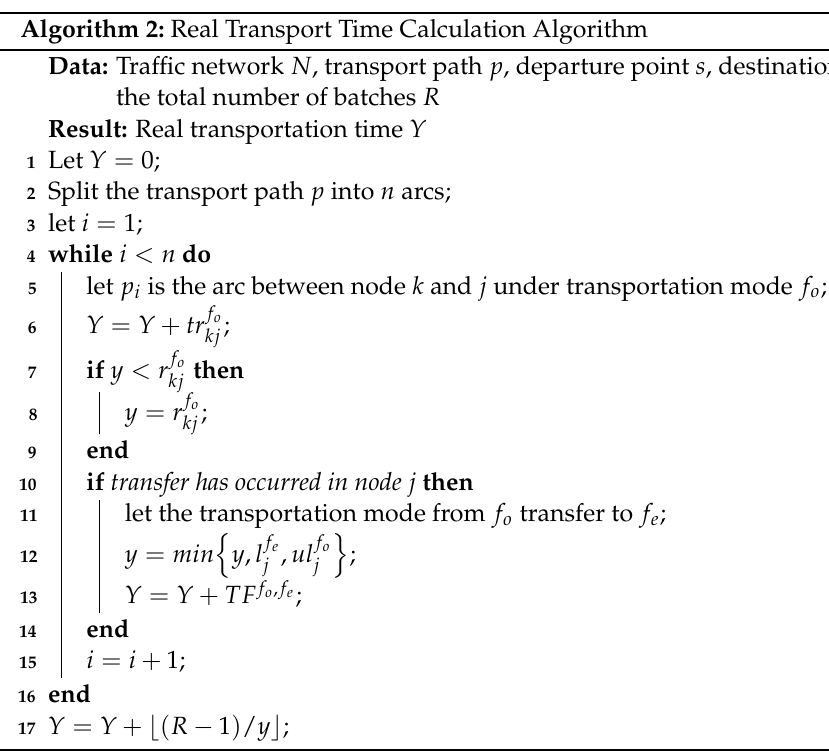
Algorithm 2: Real Transport Time Calculation